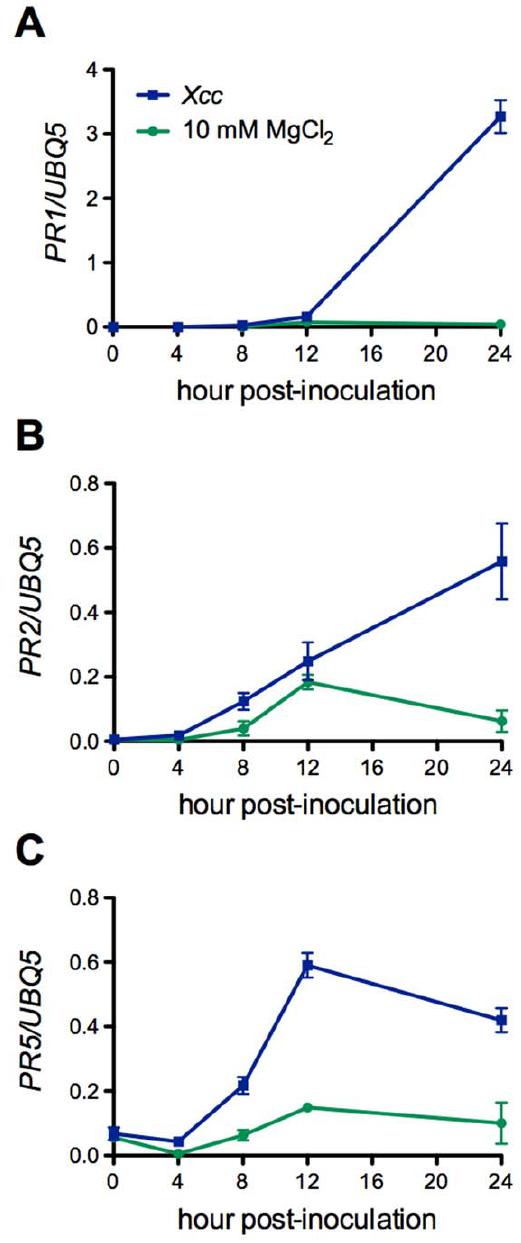
Figure 5. Xcc induces PR gene expression in Arabidopsis. ( A ) Expression of PR1 . ( B ) Expression of PR2 . ( C ) Expression of PR5 . Four- week-old Col-0 leaves were inoculated with Xcc (OD 600 =0.02) or mock- treated with 10 mM MgCl 2 . Leaf samples were collected at different time points (0, 4, 8, 12, and 24 hpi) for total RNA isolation and gene expression analysis using RT-qPCR. Expression levels were normalized against constitutively expressed UBQ5 . Data represent the mean of three biological replicates with standard deviation. The experiment was repeated twice with similar results.